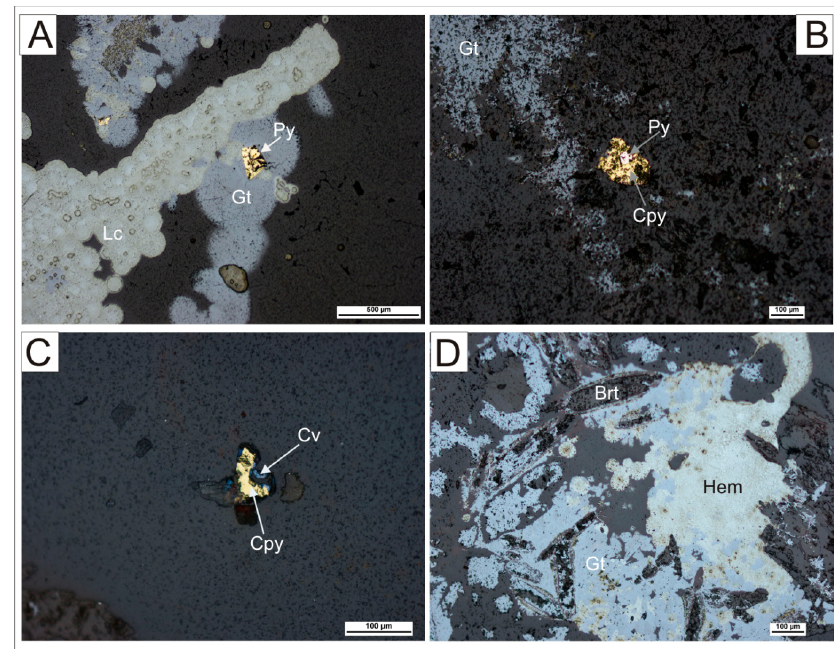
Figure 4. Images in reflected light: ( A ) kidney-shaped clusters of goethite (Gt) and lepidocrocite (Lc) and single pyrite grains (Py); ( B ) pyrite (Py) with chalcopyrite intergrowths in association with goethite; ( C ) chalcopyrite (Cpy) replaced by covellite (Cv); ( D ) large pseudomorphosis after barite filled by hematite (Hem) and goethite (Gt) with remnants of barite (Brt).